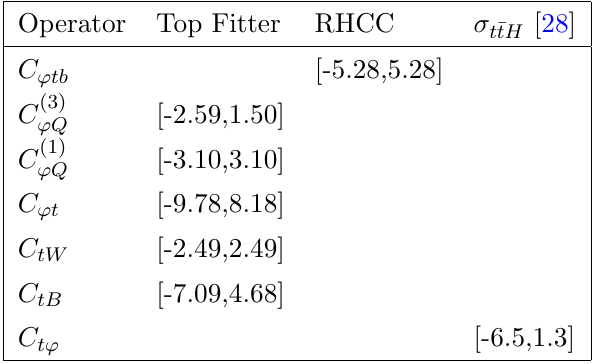
(1 = (cid:3) 4 ) for ZH production at LHC 13 TeV. O